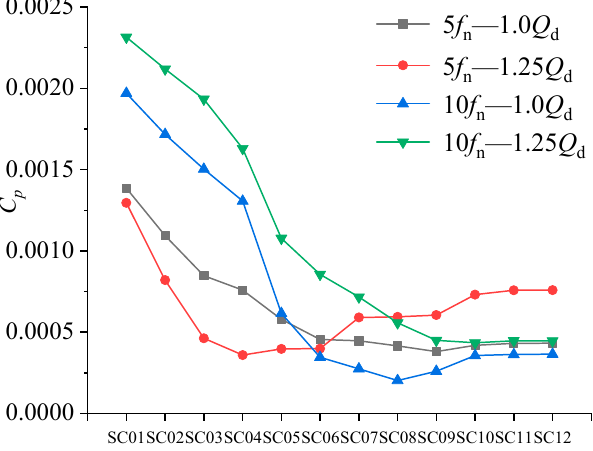
Figure 22. Frequency domain of pressure fluctuation at the mid-span of the volute.